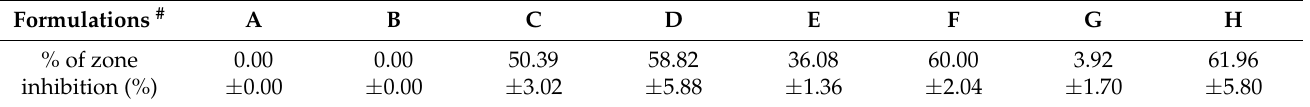
Figure 10. Antifungal activity of agar diffusion assay results using C. albicans : ( A ) control; ( B ) FLUZ suspension; ( C ) eugenol; ( D ) FLUZ in eugenol; ( E ) optimal MEs; ( F ) FLUZ-loaded optimal MEs; ( G ) two-layered MNs; and ( H ) FLUZ-MEs-loaded two-layered MNs. Table 5. The percentage of zone inhibition obtained from agar diffusion assay. (N = 3). Formulations